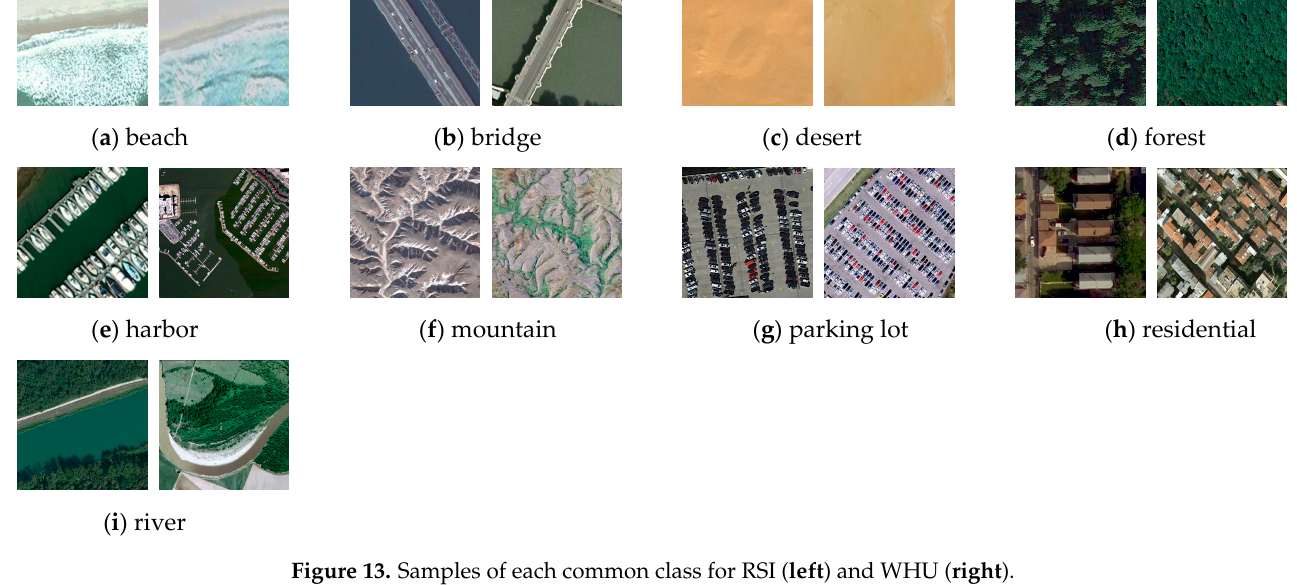
Figure 13. Samples of each common class for RSI (l eft ) and WHU ( right ).